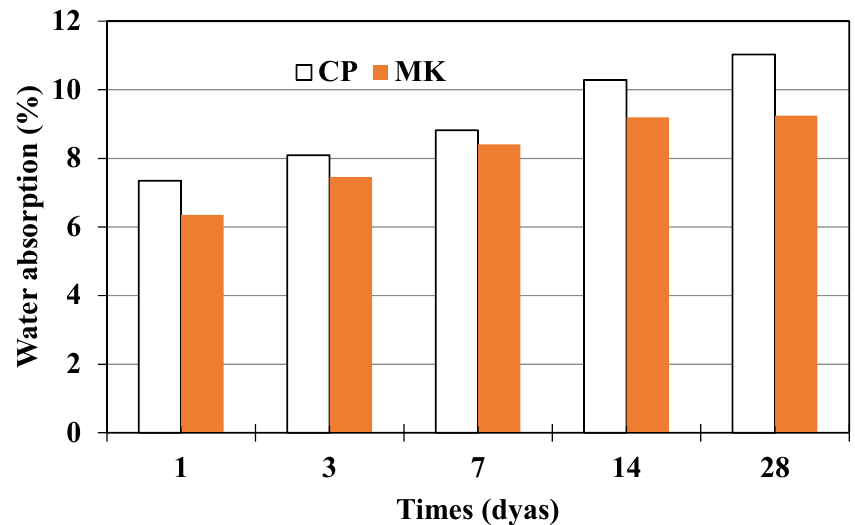
Materials 2019 , 12 , x FOR PEER REVIEW Figure 13. Water absorption of cement paste and metakaolin-cement paste. Figure 13. Water absorption of cement paste and metakaolin-cement paste.